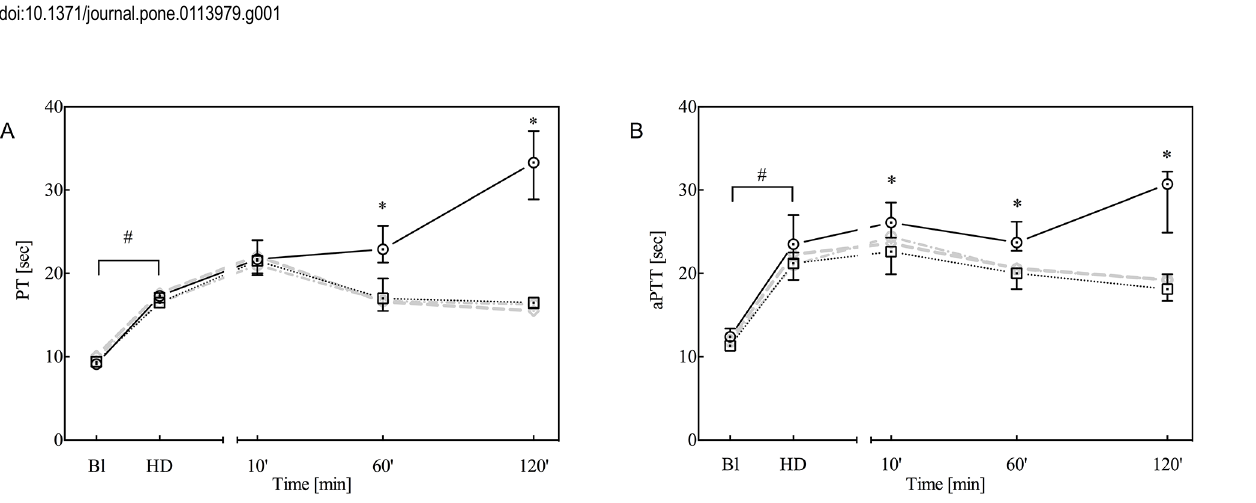
PLOS ONE | DOI:10.1371/journal.pone.0113979 June 22,